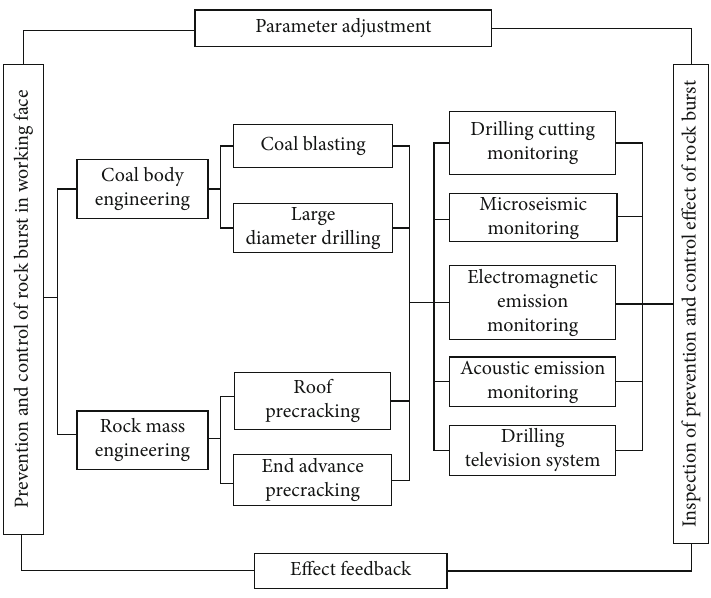
Figure 20: Prevention and control measures of rock